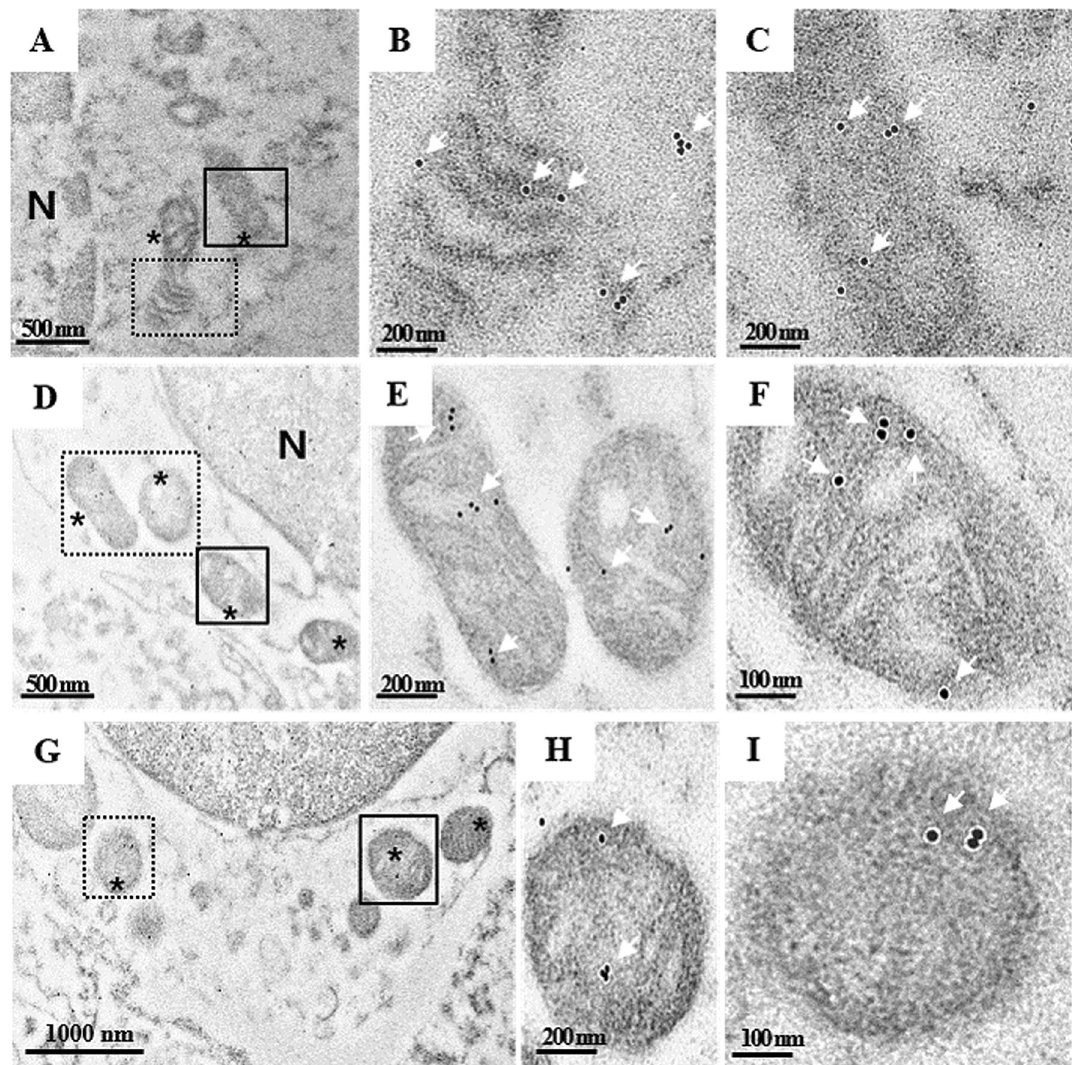
Figure 4. Subcellular localization of DAPK1 in CSF cells from SAH patients with DCI. Expression and localization of DAPK1 were analyzed by immunogold labeling under EM. ( A , D , G ) Damaged and swollen mitochondria with collapsed cristae are indicated with asterisks. Immunogold particles were mainly detected in mitochondria (white arrows). ( B , C , E , F , H , I) Enlarged boxed areas in ( A , D , G )